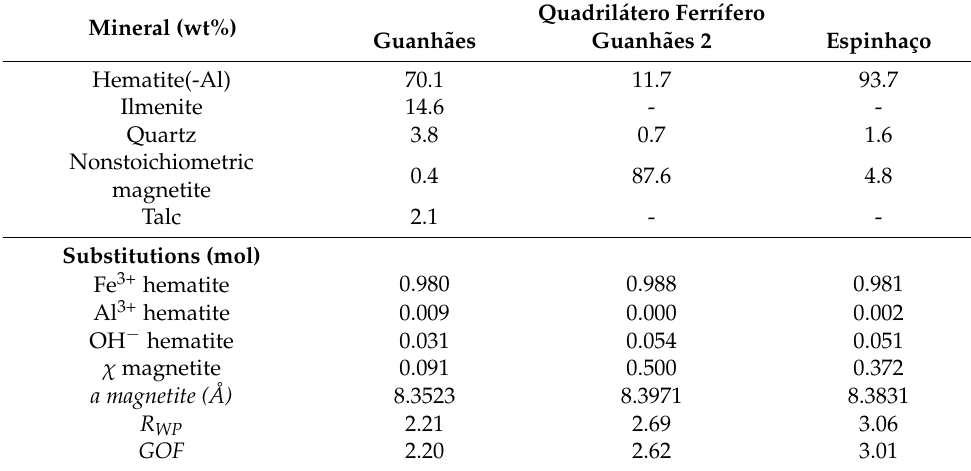
Table 2. Rietveld quantitative phase analysis, substitutions, and magnetite stoichiometry ( χ ) for iron ores from the Quadril á tero Ferr í